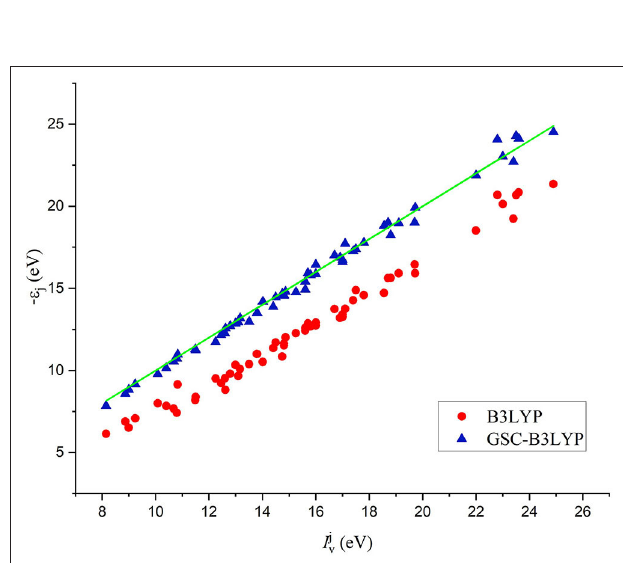
FIGURE 2 | A comparison between 56 Kohn–Sham (KS)/generalized KS (GKS) orbital energies {− ε i } calculated by B3LYP and GSC-B3LYP and the corresponding vertical ionization potentials (IPs) { I v i } measured experimentally for 12 molecules (see the main text). The green solid line indicates exact